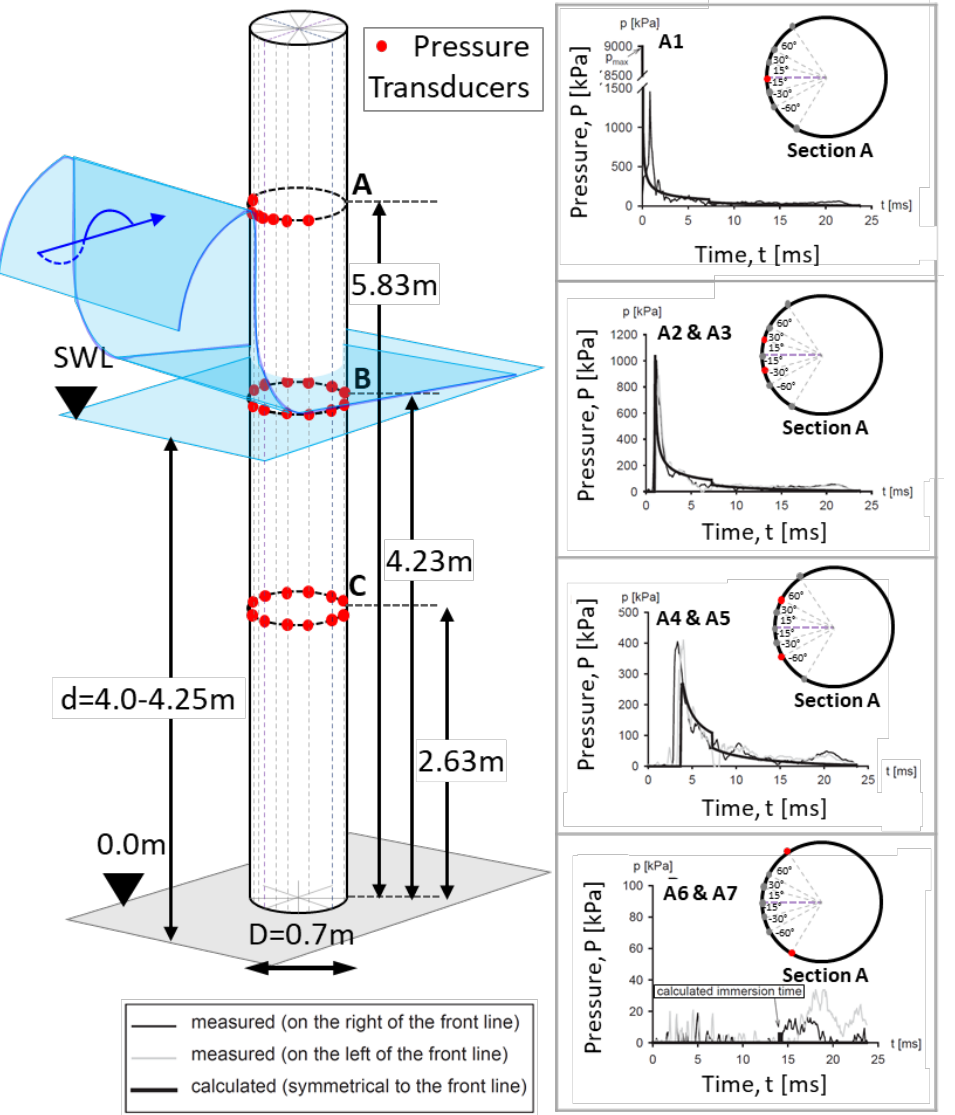
Figure 3. Azimuthal horizontal distribution of impact pressure based upon pressure measurements of Wienke and Oumeraci (2005)’s large scale experiments.